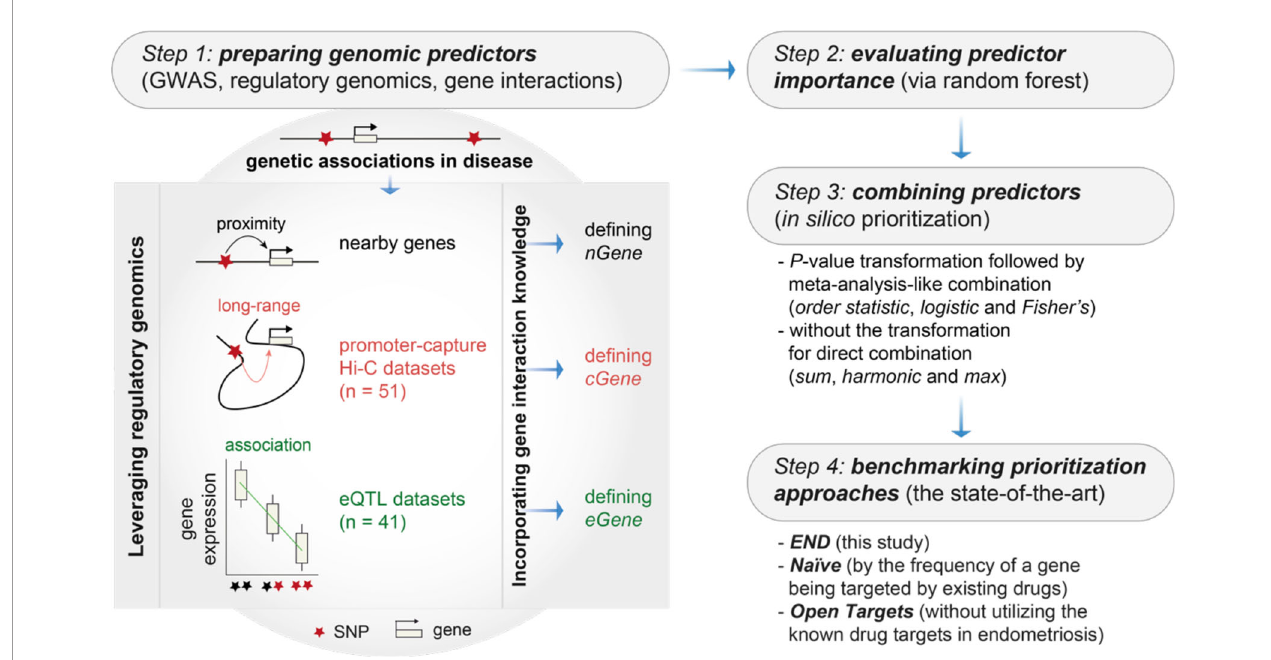
FIGURE 1 | Overview of genomics-led target prioritization in endometriosis (called ‘ END ’ ). Steps 1-3 sequentially describe how to prepare, evaluate and combine genomic predictors for in silico target prioritization. The key is the preparation of genomic predictors at Step 1, as illustrated on the right, utilizing genetic associations in disease, regulatory genomics (mainly promoter-capture Hi-C datasets and eQTL datasets) and the knowledge of gene/protein interactions. Step 4 is intended for benchmarking to compare the performance of END with two competing prioritization approaches, including Naïve (a gene prioritized simply according to how often the gene is already targeted by existing drugs) and Open Targets (without utilizing the information of known drug targets). GWAS, genome-wide association studies; nGene , nearby genes; cGene , conformation genes; eGene , expression